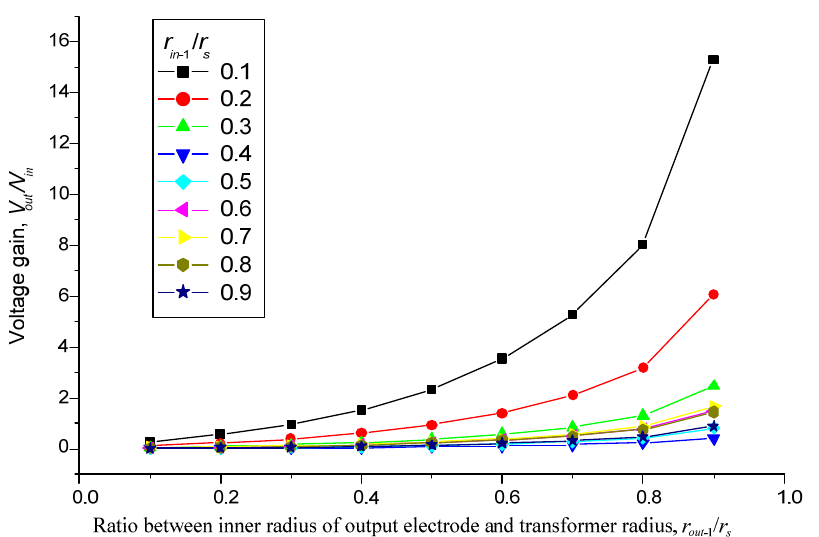
Table 3. The comparison of analytical solutions and measurement results with different radius ratio.